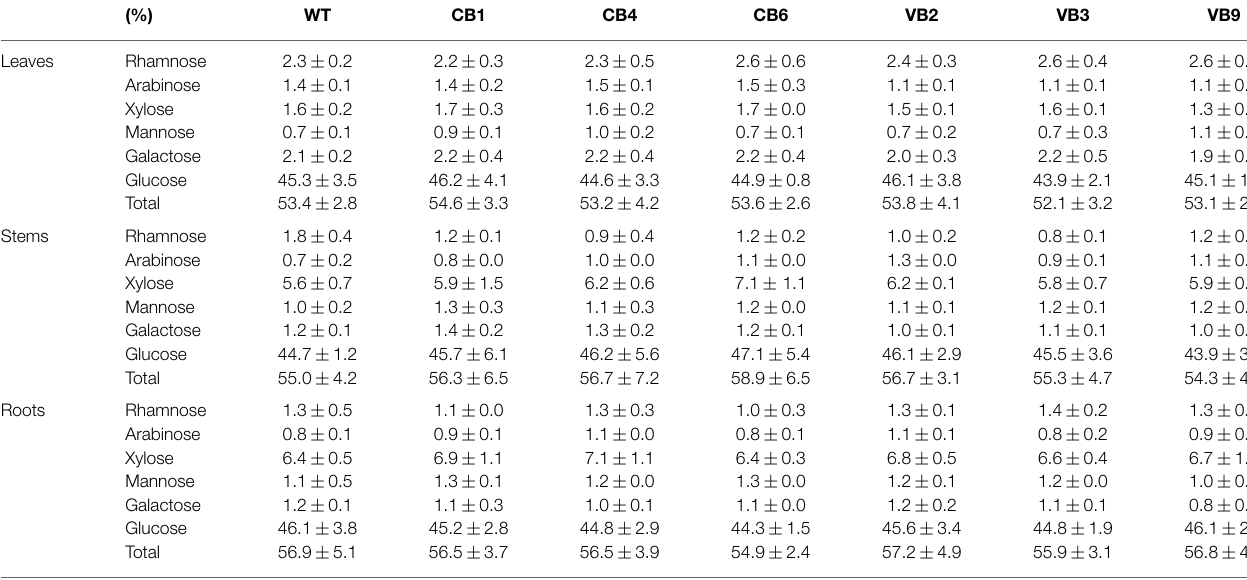
TABLE 1 | Comparison of carbohydrate content in leaves, stem, and roots in WT and vacuole-targeted T. maritima BglB transgenic plants